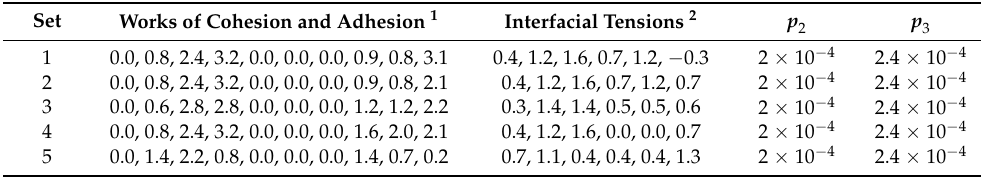
Table 1. Computer simulation parameters.